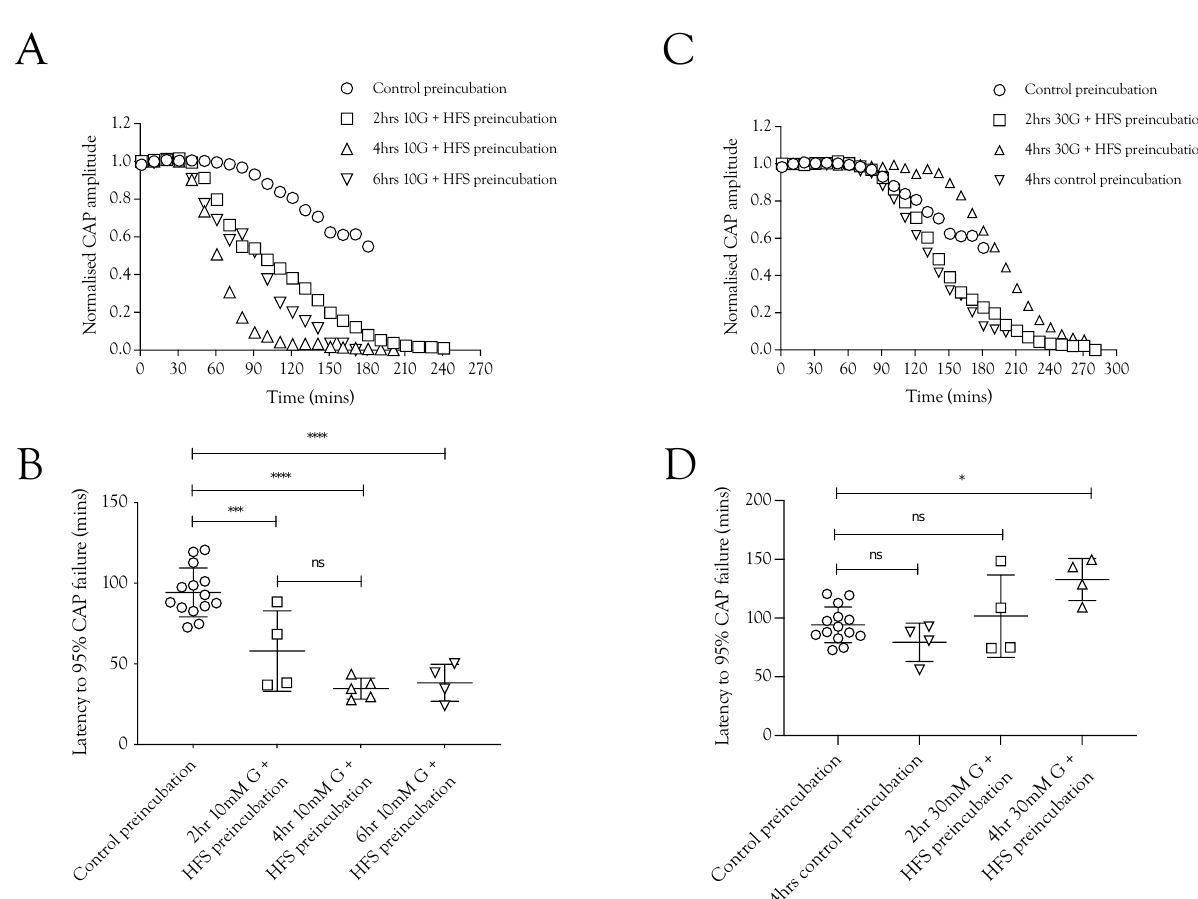
Figure 4. Glycogen is metabolised during normoglycemia (10 mM glucose) and HFS but synthesised during increased glucose supply and HFS. ( A ) Conduction failure during removal of exogenous energy substrate supply was accelerated as a result of exposure to HFS when supplied with 10 mM glucose compared to baseline conditions. ( B ) The latency to CAP failure decreased from 94.3 ± 15.1 min ( n =14) to 58 ± 24.9 min ( n = 4) after 2 h pre-incubation in 10 mM glucose with HFS, an effect that was not significantly increased when the duration was increased to 4 h (34.7 ± 6.5 min, n = 5) or 6 h (38.3 ± 11.5 min, n = 4). ( C ) Pre-incubating the nerve in 10 mM glucose and HFS for increasing durations reduced the latency to A fibre CAP failure during subsequent substrate-free conditions. ( D ) Latency to A fibre CAP failure during substrate-free conditions was increased from 79.5 ± 16.3 min ( n = 4) to 94.3 ± 15.1 min ( n = 14) when the pre-incubation duration was increased in 30 mM glucose to 4 h. Greater increases in the latency to CAP failure occurred as a result of increasing the glucose to 30 mM, where latency increased to 101.7 ± 35.1 min after 2 h ( n = 4) and 132.8 ± 18.0 min after 4 h ( n = 4) (**** = p ≤ 0.0001, *** = p ≤ 0.001, * = p ≤ 0.05, ns = not